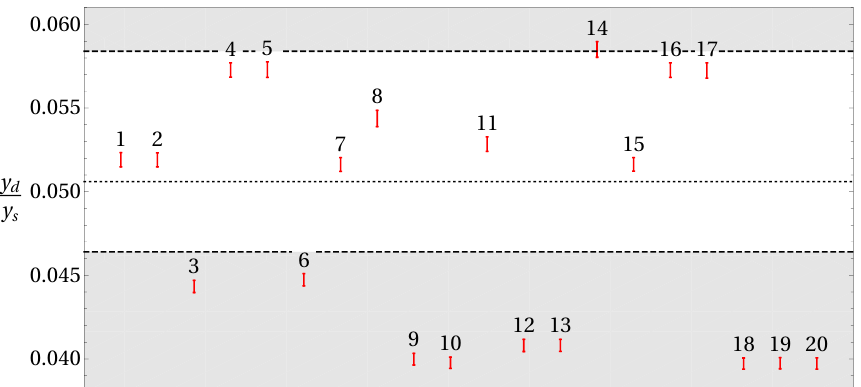
Figure 5 . Predictions for the Yukawa ratio y d =y s . For each combination of CG coe(cid:14)cients listed in table 2 the 1 (cid:27) HPD intervals for y d =y s are shown as red lines. The HPD intervals do not depend on the choice of the CSD2 scenario. The dotted line indicates the experimental central value of the Yukawa ratio and the grey areas represent the regions outside the experimental 1 (cid:27) range, given by y d =y s = 5 : 06 +0 : 78 (cid:1) 10 (cid:0) 2 [64]. (cid:0) 0 : 42